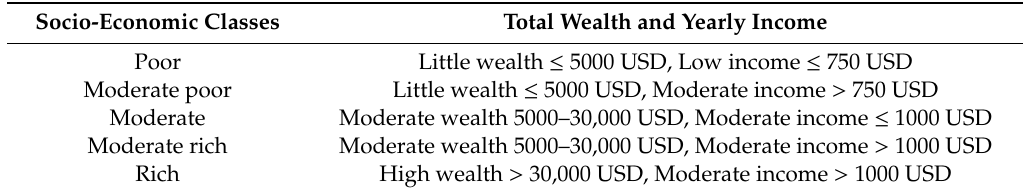
Table 2. Classification of socio-economic status of the people in the study area.